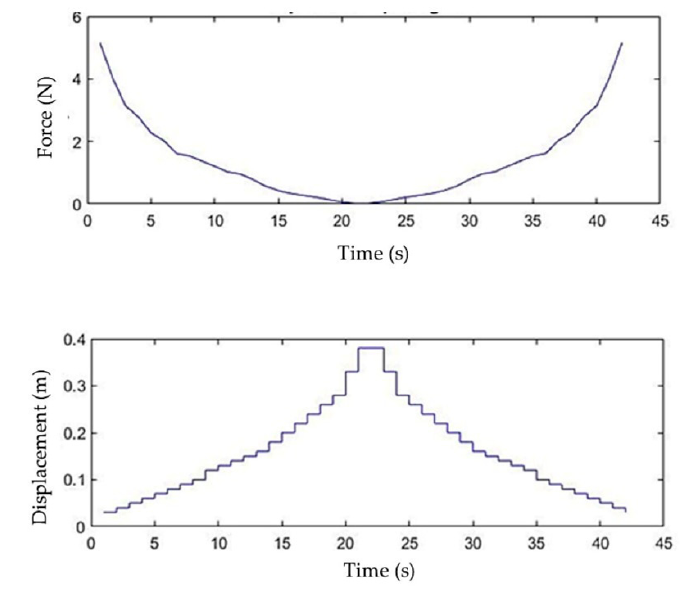
Figure 3. Interaction of displacement–force between magnets.